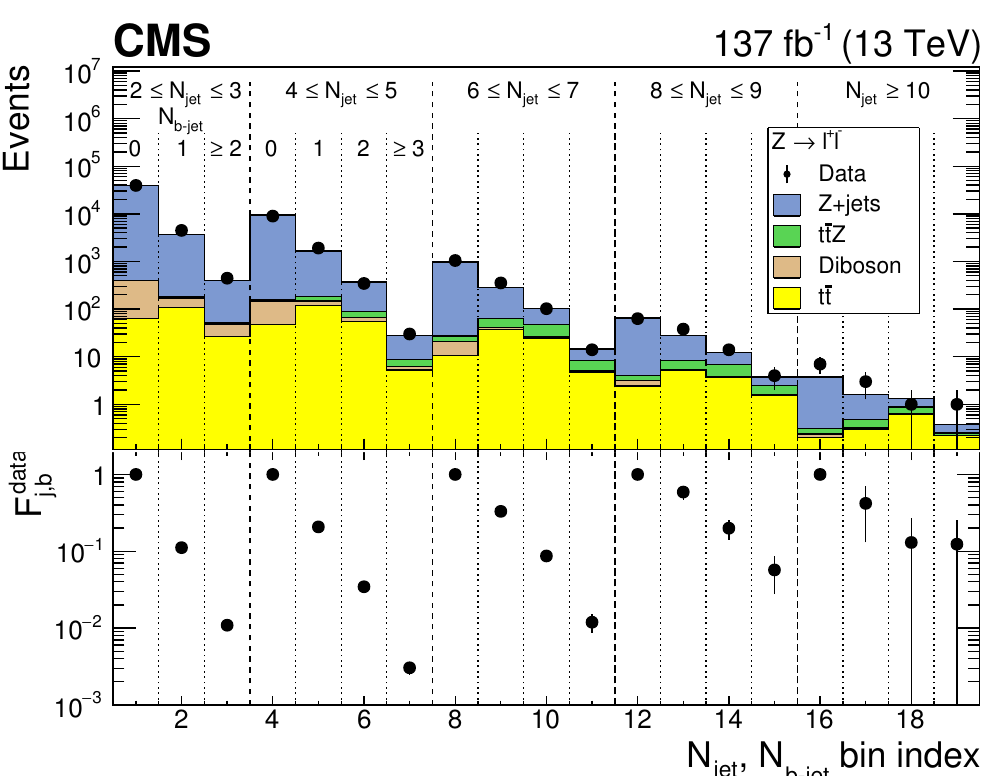
Figure 6 . (Upper) The observed event yield in the Z( ! ‘ + ‘ (cid:0) )+jets control region, integrated over H and H miss , as a function of N and N . The uncertainties are statistical only. The stacked T T jet b-jet histograms show the corresponding results from simulation. (lower) The extrapolation factors F data with their statistical